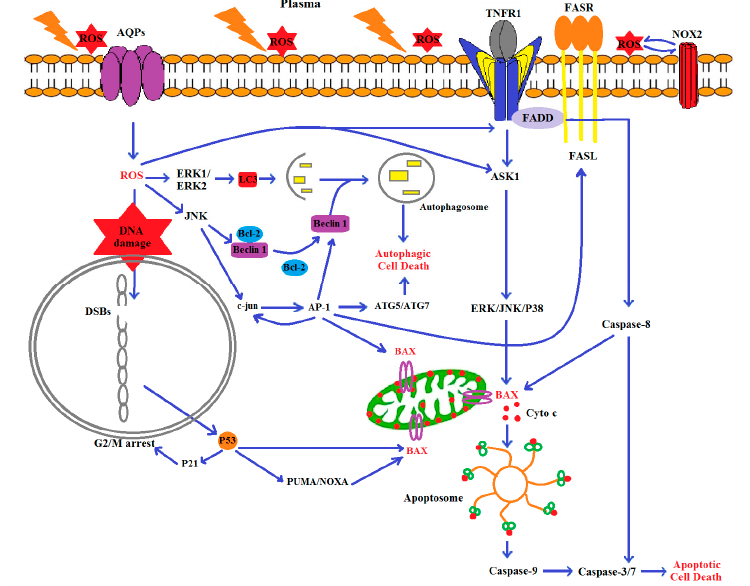
Figure 9. Schematic model of the molecular signal pathway of the proposed cell death crosstalk in B16 cells exposed to plasma induced-ROS. In short, CAP-induced ROS cause oxidative stress. The excessive intracellular ROS can, in turn, activate the TNF-R1 pathway, which leads to ASK1 activation and downstream stimulation of ERK, JNK, or p38. Phosphorylated JNK activates the pro-apoptotic protein, Bax. Bax translocates to the mitochondria and triggers the release of cytochrome C into the cytosol, leading to the activation of caspase-3 / 7 and eventually causes apoptotic cell death. Intracellular ROS can also suppress cell growth by inducing DNA double-strand breaks (DSBs) and upregulating p53 antitumor activity. P53 arrests the cell cycle via P21 and increases apoptosis based on the mitochondrial pathway by enhancing PUMA / NOXA / Bax. By contrast, ROS can directly stimulate ERK1 / ERK2 and JNK. ERK1 / ERK2 can induce LC3. JNK phosphorylates Bcl-2 and releases beclin1 associated with LC3 that is involved in autophagic cell death. Alternatively, JNK can induce c-jun phosphorylation. Phospho-c-jun induces AP-1 production, which in turn increases the expression of many genes such as c-jun, beclin 1, Atg5 / 7, Bax, and FasL. Beclin 1 and Atg 5 / 7 stimulate autophagic cell death, and FasL can induce Fas receptor (Fas-R) expression and activate caspase 8, which in turn stimulates